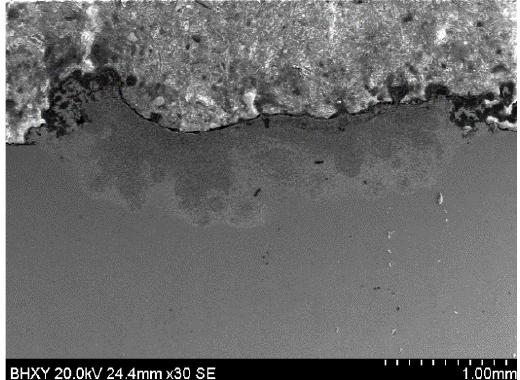
Figure 2. Cross-section morphology of the G@Ni single track.